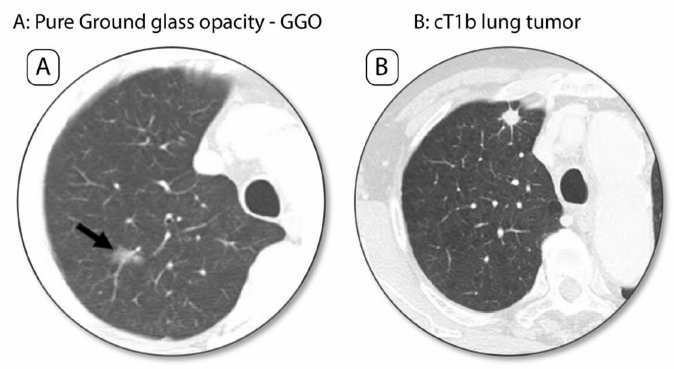
Figure 1. Early-stage lung cancer on screening CT scan. ( A ) Pure Ground glass-opacity (GGO) in the right upper lobe. ( B ) Lung cancer nodule, cT1b as a densified lung